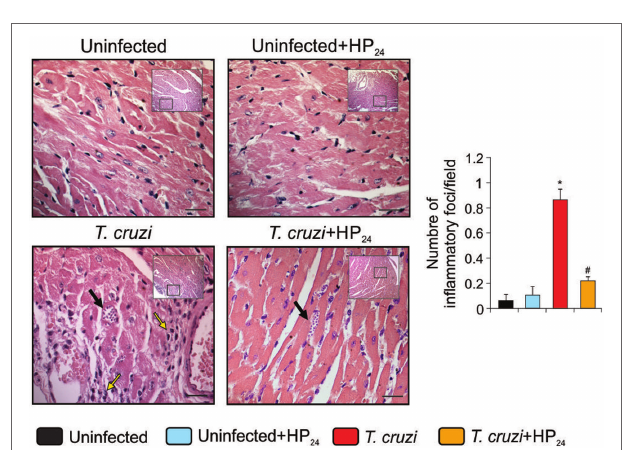
FigUre 6 | HP 24 reduces heart inflammatory reaction in Trypanosoma cruzi -infected mice. Heart inflammatory reaction and parasite nests were analyzed at 10 dpi in histological sections of T. cruzi -infected, T. cruzi -infected HP 24 -treated, and uninfected mice, stained with hematoxilin–eosin (bar: 100 µm, yellow arrows, inflammatory infiltrates, black arrows, amastigote nests). Results represent the mean ± SEM of three independent experiments (five mice per group). * P < 0.05 vs. uninfected mice, # P < 0.05 vs. T. cruzi -infected mice.